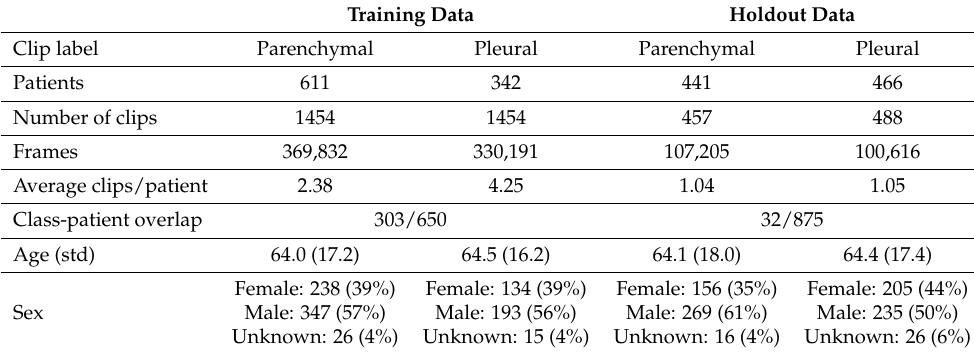
Table 1. Characteristics of the datasets used for view classifier training and